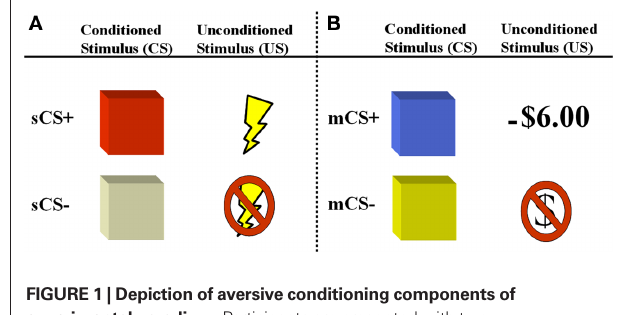
Figure 1 | Depiction of aversive conditioning components of experimental paradigm. Participants are presented with two counterbalanced aversive conditioning sessions following a gambling game where they earn a monetary endowment. (A) In the first session, the unconditioned stimulus is a mild electric shock (primary reinforcer) which is paired with a colored square (sCS + ). (B) In the second session, the unconditioned stimulus is a monetary loss ( − $6.00), which is paired with a different colored square (mCS + ) and detracted from the total sum earned during the gambling